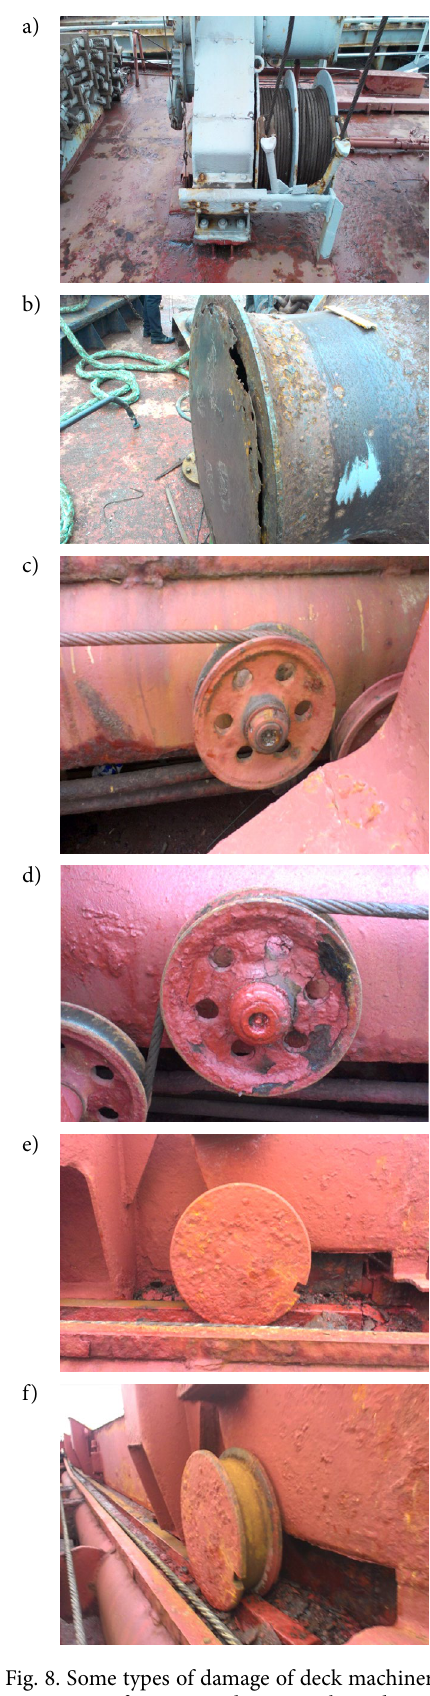
Fig. 8. Some types of damage of deck machinery